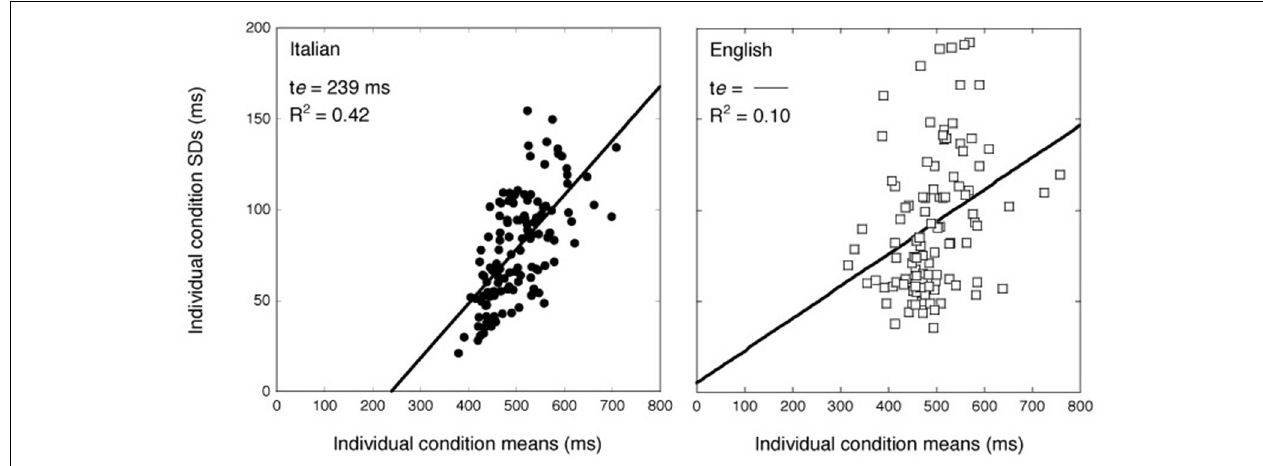
FIGURE 4 | Individual participants’ SDs over items as a function of mean vRTs. On the left Italian readers; on the right, English participants. The solid line represents the best fit of the DEM to the data (Myerson et al.,